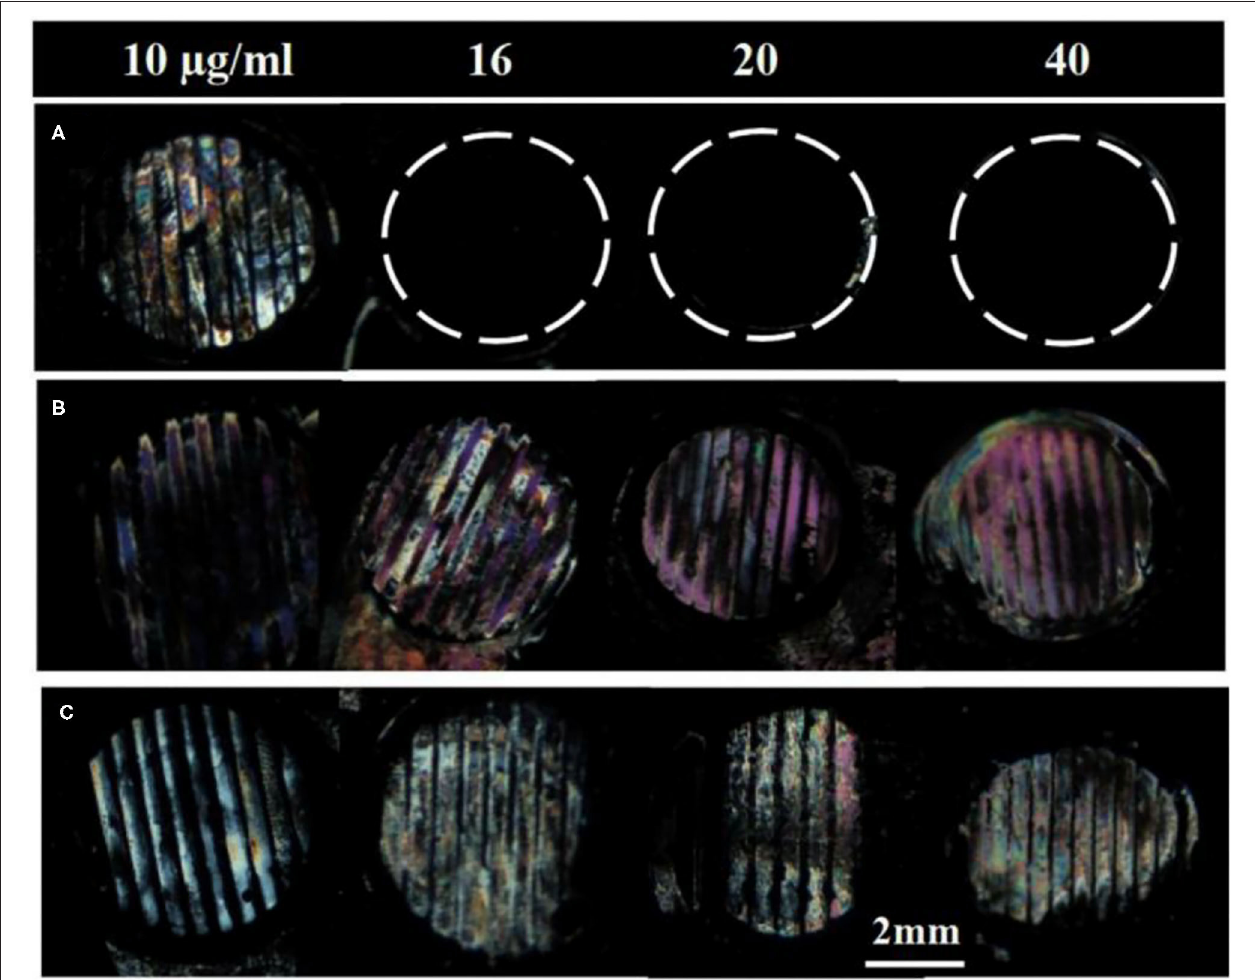
FIGURE 3 | Effect of aptamers solution concentrations on the removal of surface-immobilized (A) gp-120, (B) BSA, and (C) gp-120. Numbers above are concentration of Aptamer solution used in the study, B40t77 in (A,B) whereas Apt 8 in case of (C) . Optical images of LC show that surface-immobilized gp-120 can be released from the surface only when the concentration of B40t77 was 16 µ g/ml or higher whereas bright images were observed in case of BSA treated with B40t77and gp-120 treated with Apt 8 instead of B40t77.